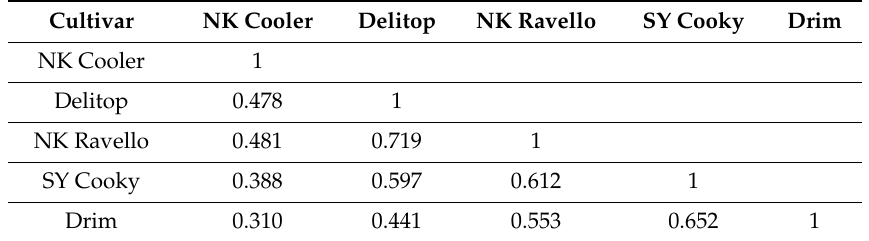
Table 7. Genetic similarity among the studied five cultivars of maize based on 112 SSR